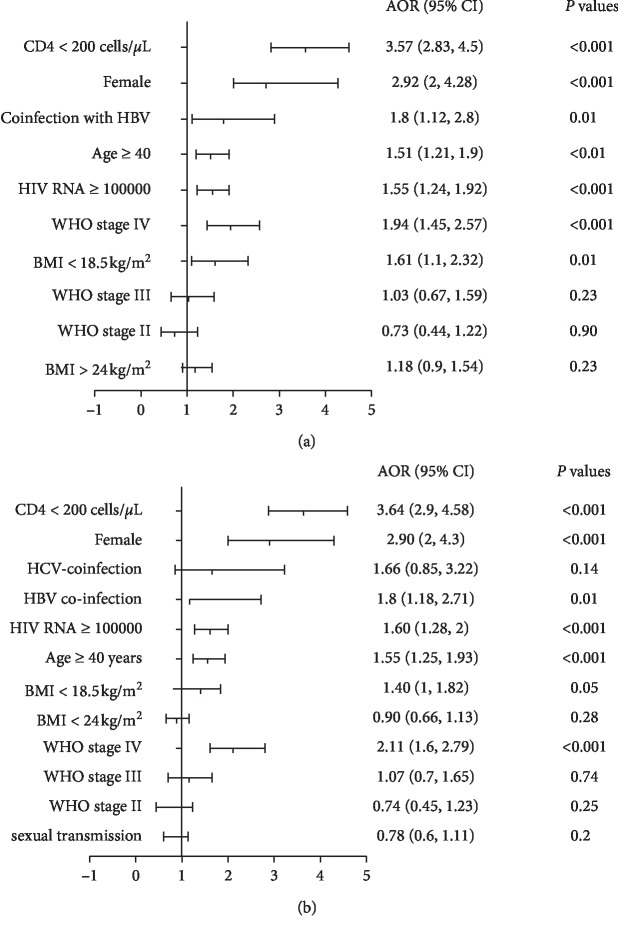
The forest plot of logistic analysis for cytopenias at baseline. (a) Binary logistic regression analysis for cytopenia. (b) Ordinal logistics regression analysis for unicytopenia, bicytopenia, and pancytopenia.